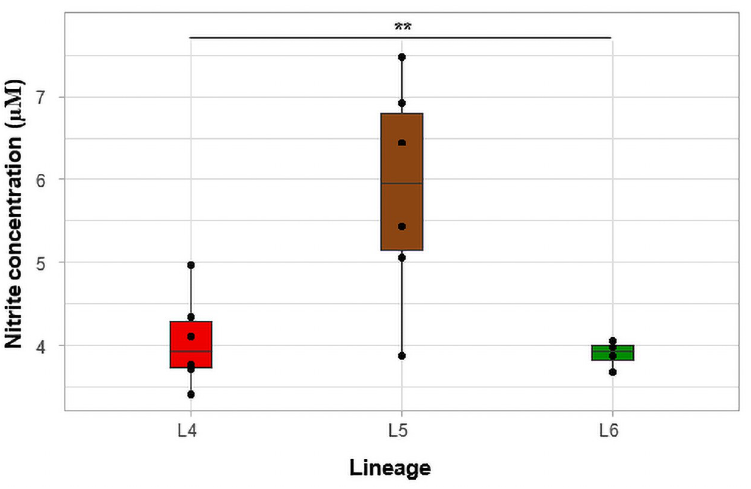
Fig 5. Comparison of nitrite concentration. The individual isolates are represented by the black points in the boxplot.